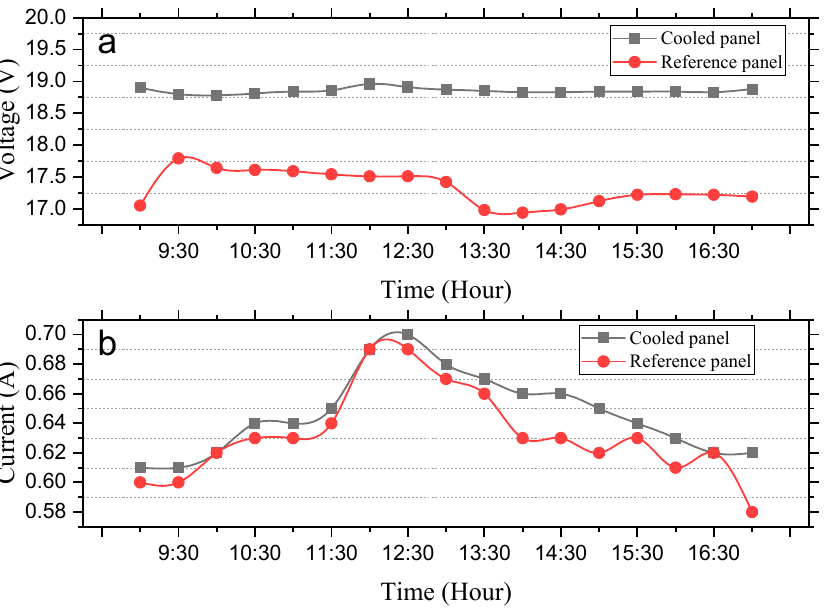
Figure 9. ( a ) Voltage, ( b ) current for the cooled and referenced panel.